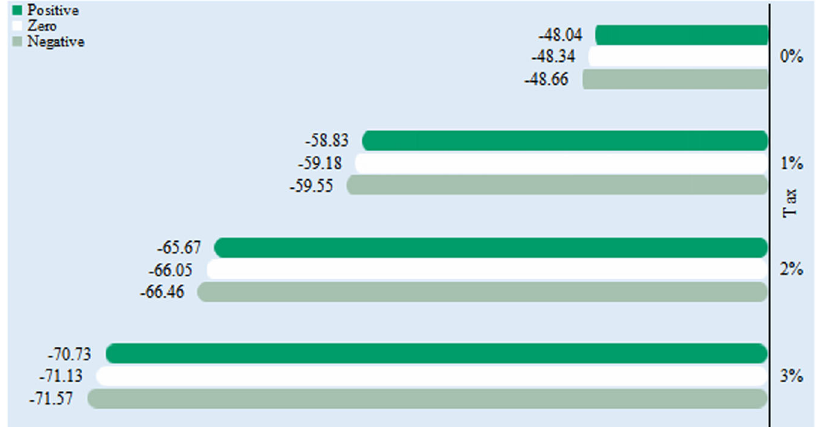
Fig. 2 Impacts of climate damages ( ξ ) on relative utility (unit: 10 9 CNY). Shows impacts of climate damage on relative utility: the legends “ Positive ” , “ Zero ” , and “ Negative ” denote the positive, zero, and negative ξ